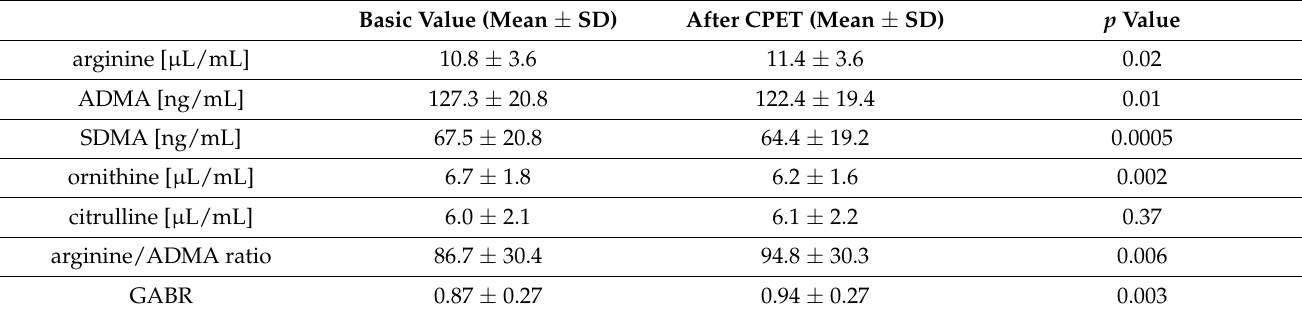
Table 2. Changes in arginine derivatives after cardiopulmonary exercise test. ADMA = asymmetric dimethylarginine, CPET = cardiopulmonary exercise test, GABR = global arginine bioavailability ratio, SDMA = symmetric